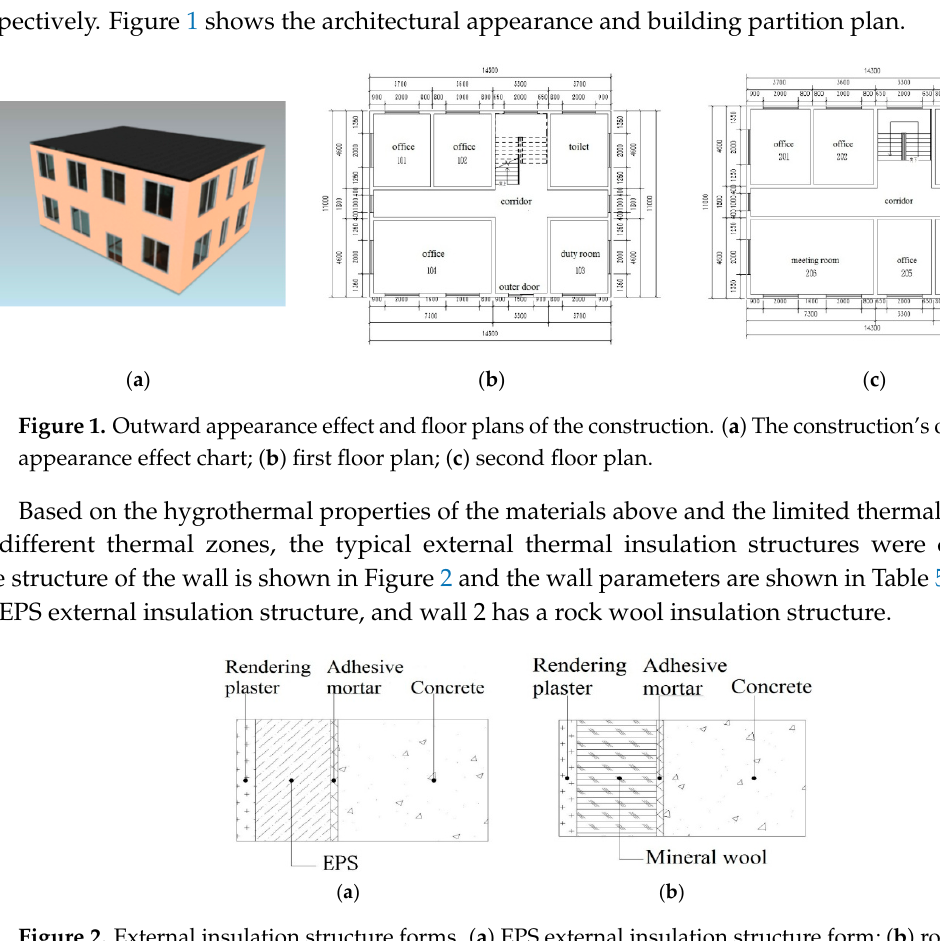
Figure 2. External insulation structure forms. ( a ) EPS external insulation structure form; ( b ) rock wool external insulation structure form. Table 5. Structure of building enclosure in different regions.